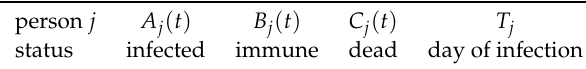
Table A2. Let the current status of individual j among a population with P members at time t be characterized by a quadruplet ( A j , B j , C j , T j ) with j ∈ { 1,2,.., P } carrying for each individual four pieces of information as detailed in the table. While the identifiers A j , B j , C j carry binary information (1 = true, 0 = false) at time t , T j carries the time (a day number) at which person j got infected ( T j = − 1, if this never happened). From these ’status’ quadruplets one can deduce, via the Monte Carlo algorithm described in the text part, quantities usually reported such as the daily number d ( t ) of fatalities. In addition, one has access to usually unknown true number of newly infected, currently infected, immune, never infected, deceased individuals, and their cumulative